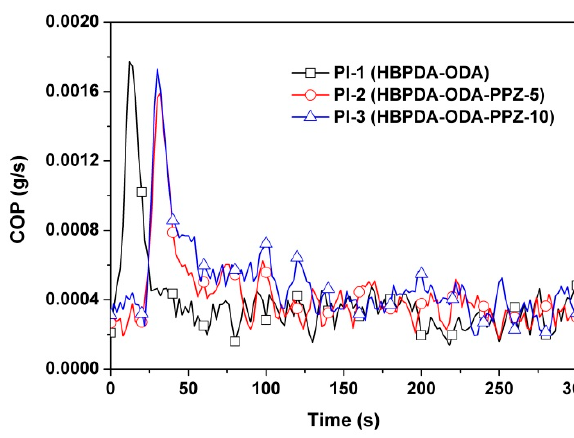
Figure 14. RSR plots of PI films.